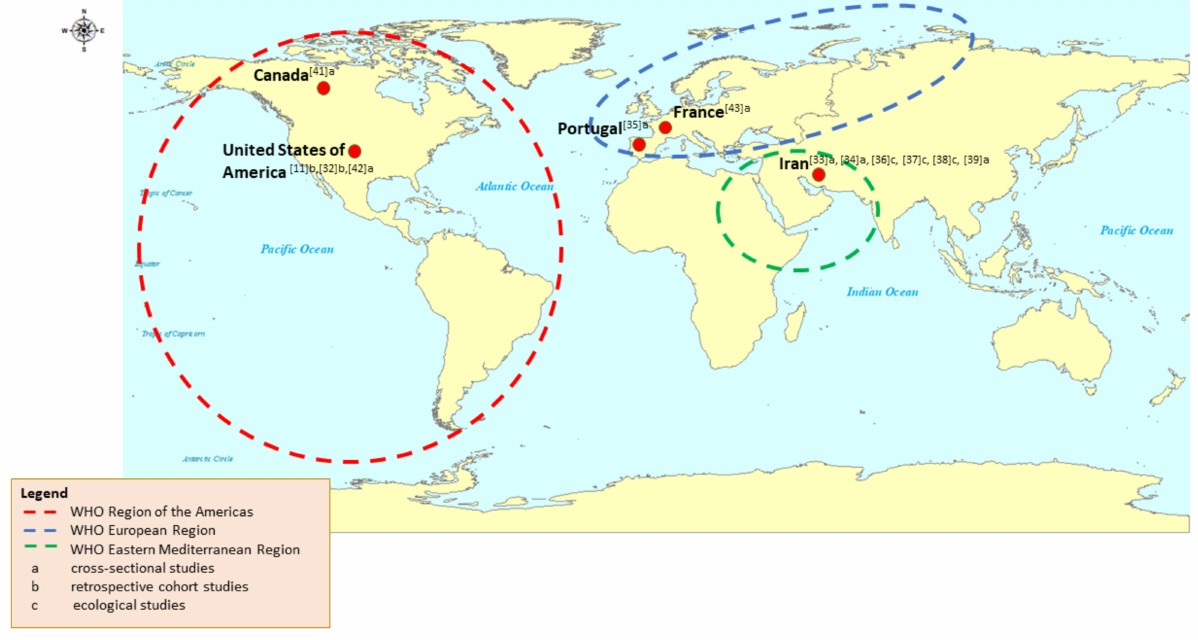
Figure 2. Distribution of included articles based on countries, WHO regions and study